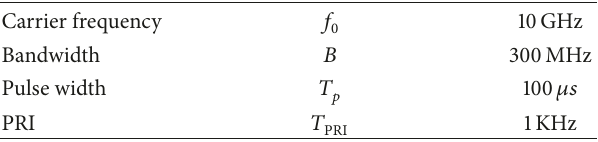
Table 1: The simulation